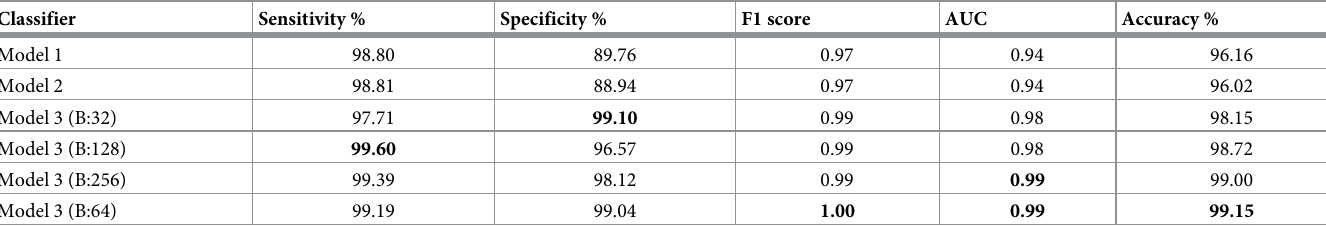
Table 2. Overall performance for different CNN